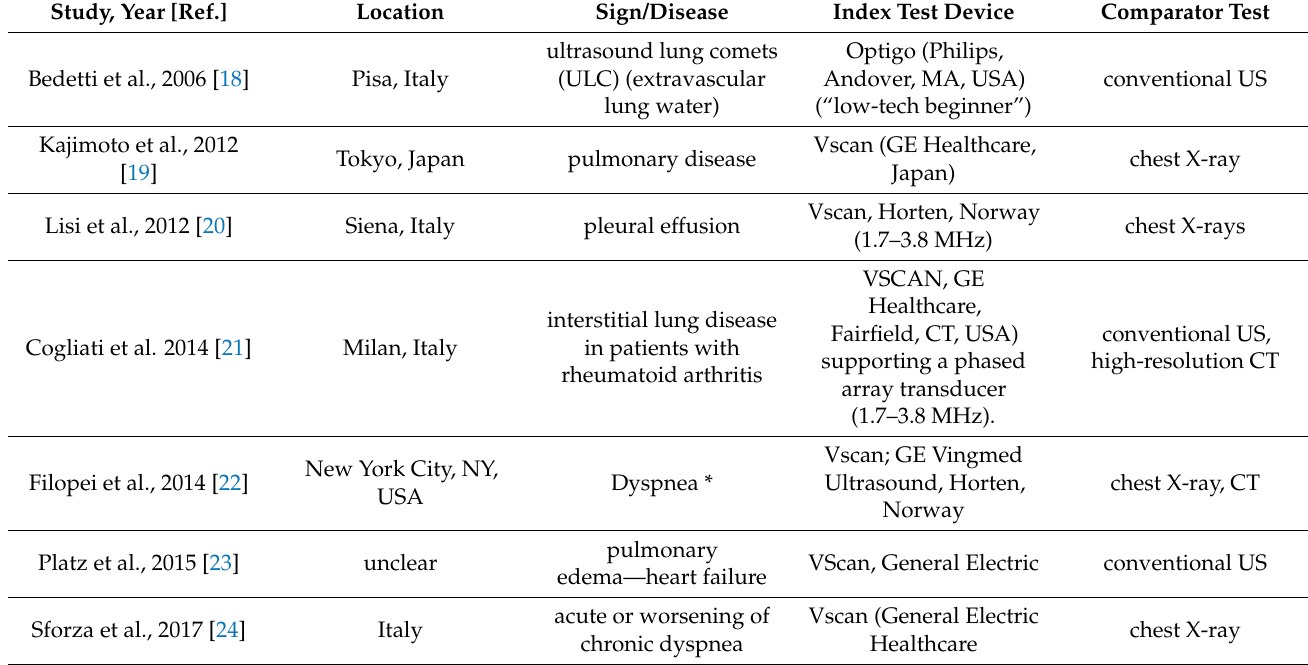
Figure 1. Flowchart of the literature screening (HHUS = Hand-Held UltraSound). Table 1. Characteristics of the reviewed